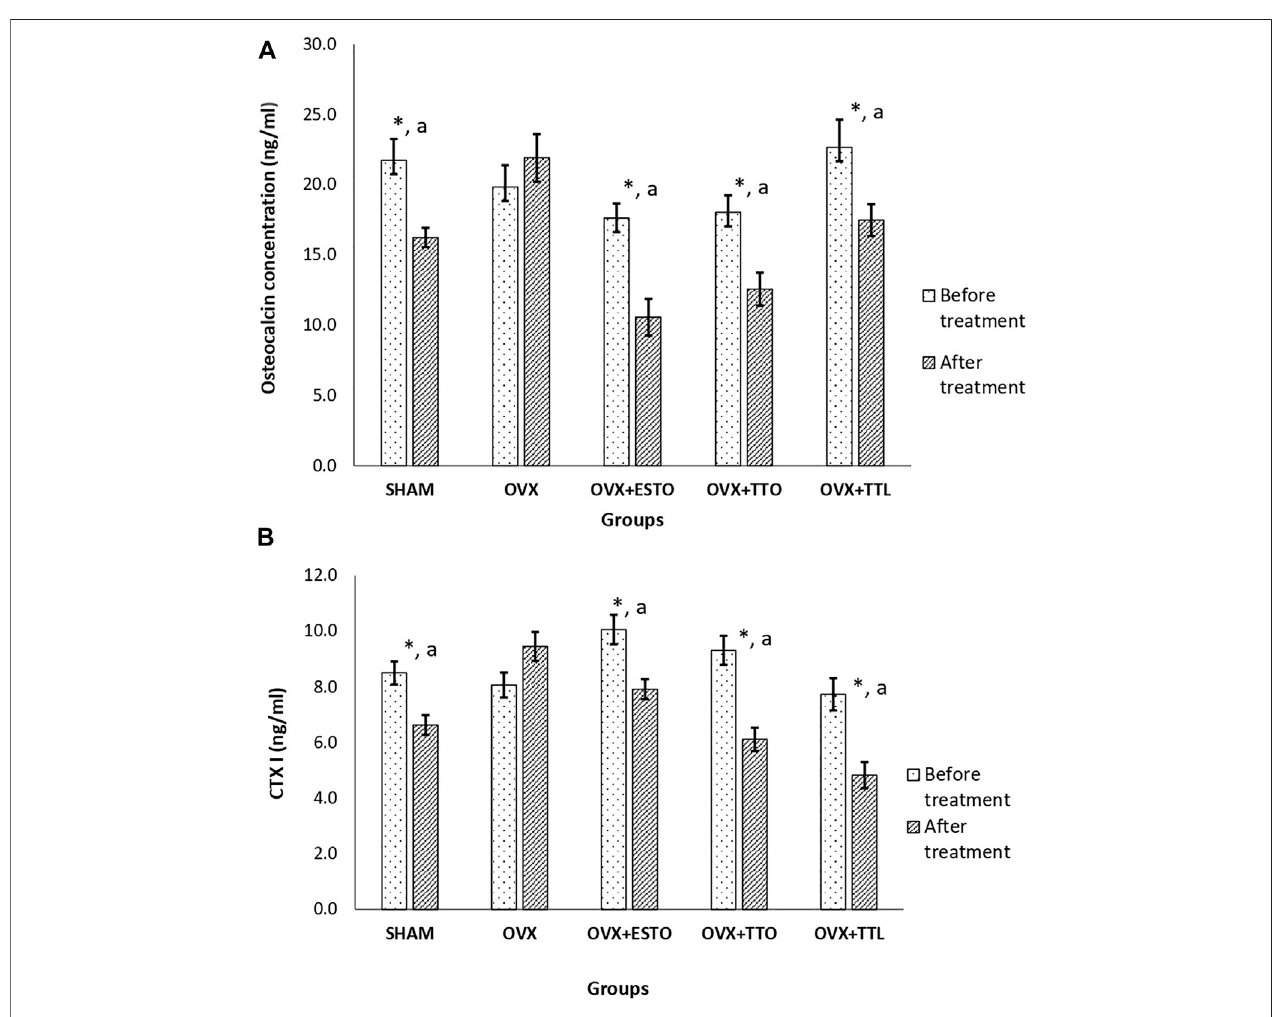
FIGURE 3 | Bone biochemical markers (pre- and posttreatment). (A) Pretreatment and posttreatment levels of osteocalcin. (B) Pretreatment and posttreatment levelsofCTX1.SHAM,sham-operatedgroup;OVX,ovariectomizedcontrolgroup;OVX+ESTO,ovariectomized+oralestrogen;OVX+TTO,ovariectomized+dailyoral tocotrienol; OVX + TTL, ovariectomized + IO injection of tocotrienol + PLGA. *Signi fi cant difference ( p < 0.05) when compared before and after treatment a Signi fi cant difference ( p < 0.05) when compared with the ovariectomized control group (OVX). The data are expressed as mean ± SEM.